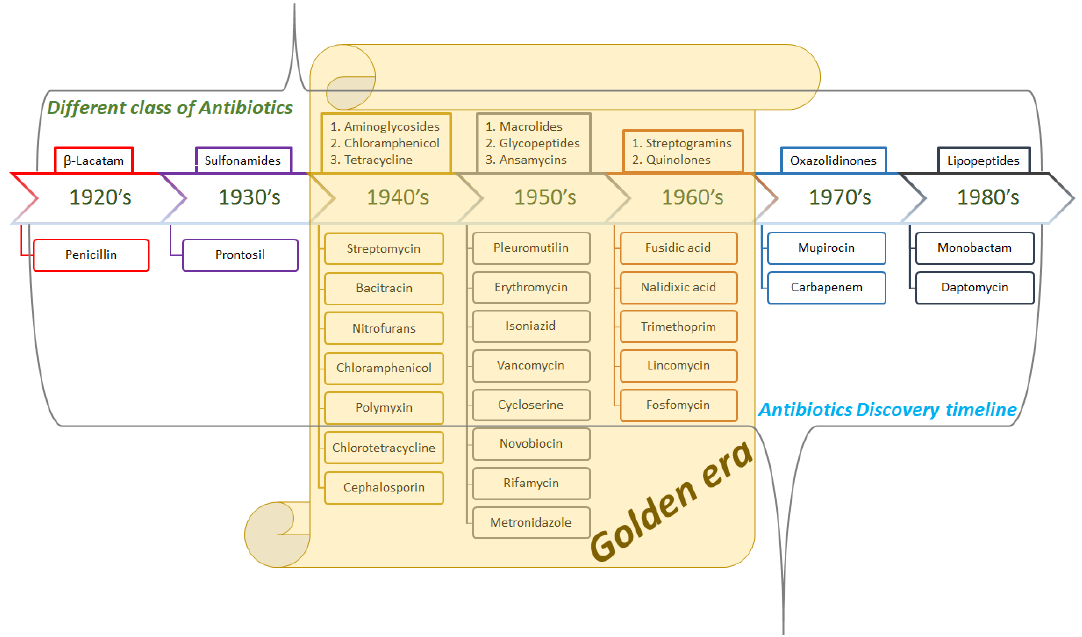
Figure 1. Schematic representation of the brief history of antibiotic treatments leading up to the surge in antibiotic resistance.